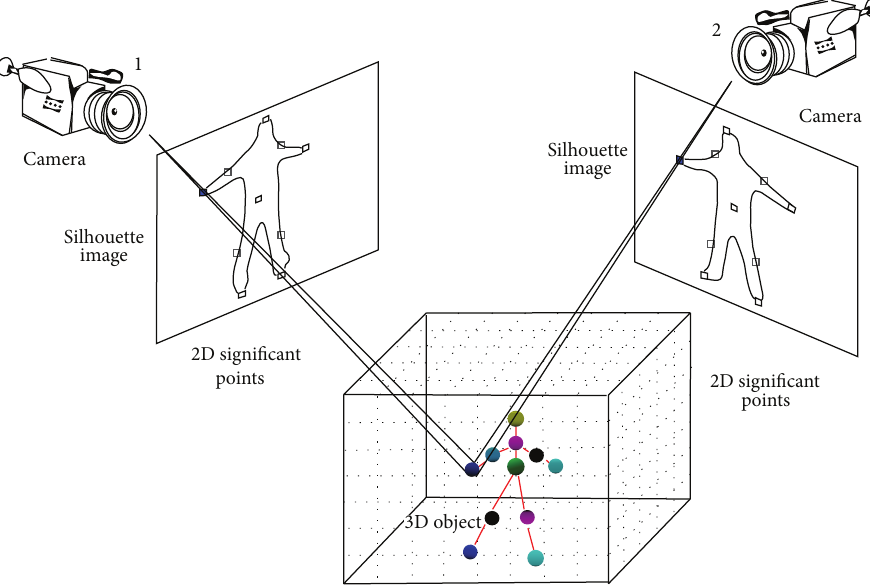
Figure 8: Construction of the 3D location of the tip of a human hand using the SPVM